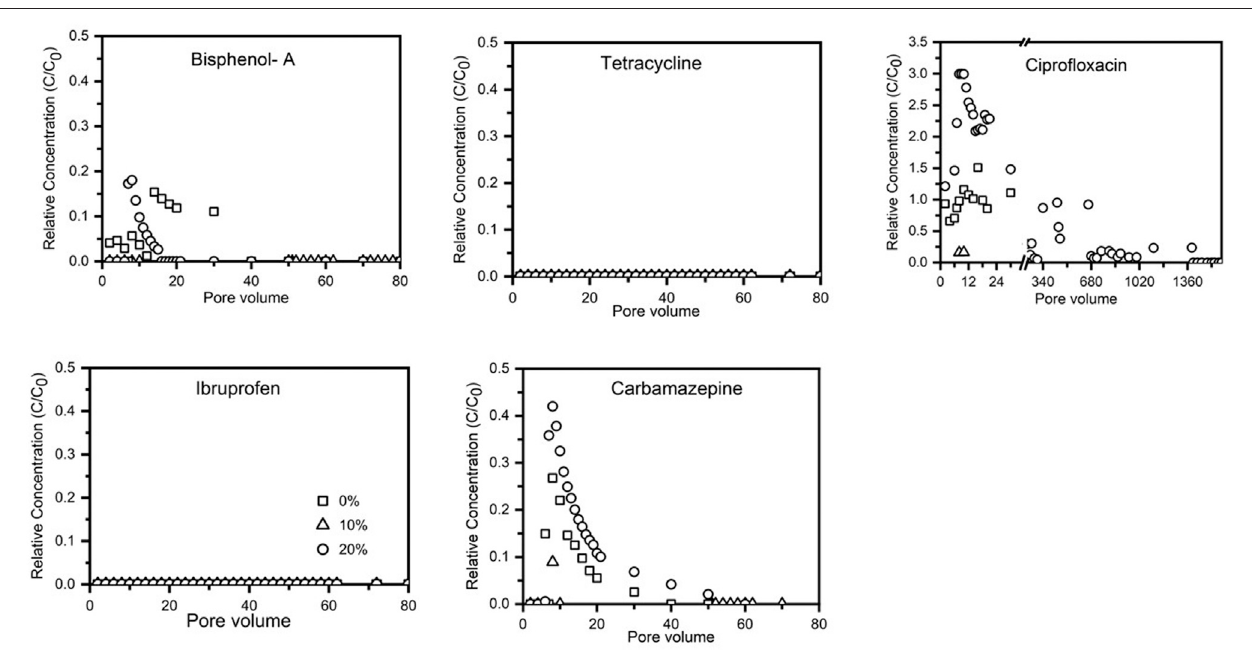
FIGURE 4 | Breakthrough and elution of PPCPs from sand columns containing 0, 10, and 20% birnessite-coated sand.